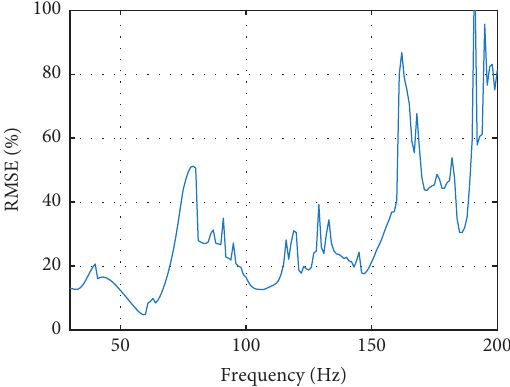
Figure 9: RMSE under the excitation of three